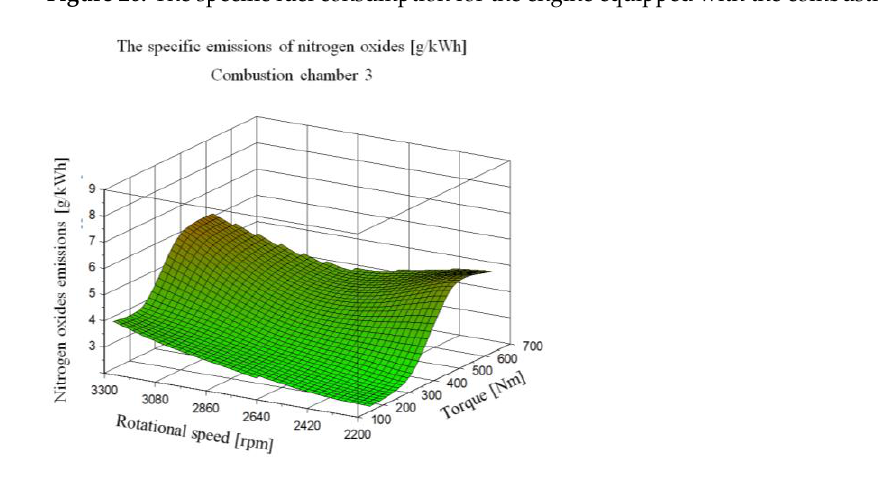
Figure 27. The nitrogen oxides emission of the engine equipped with the combustion chamber 3.